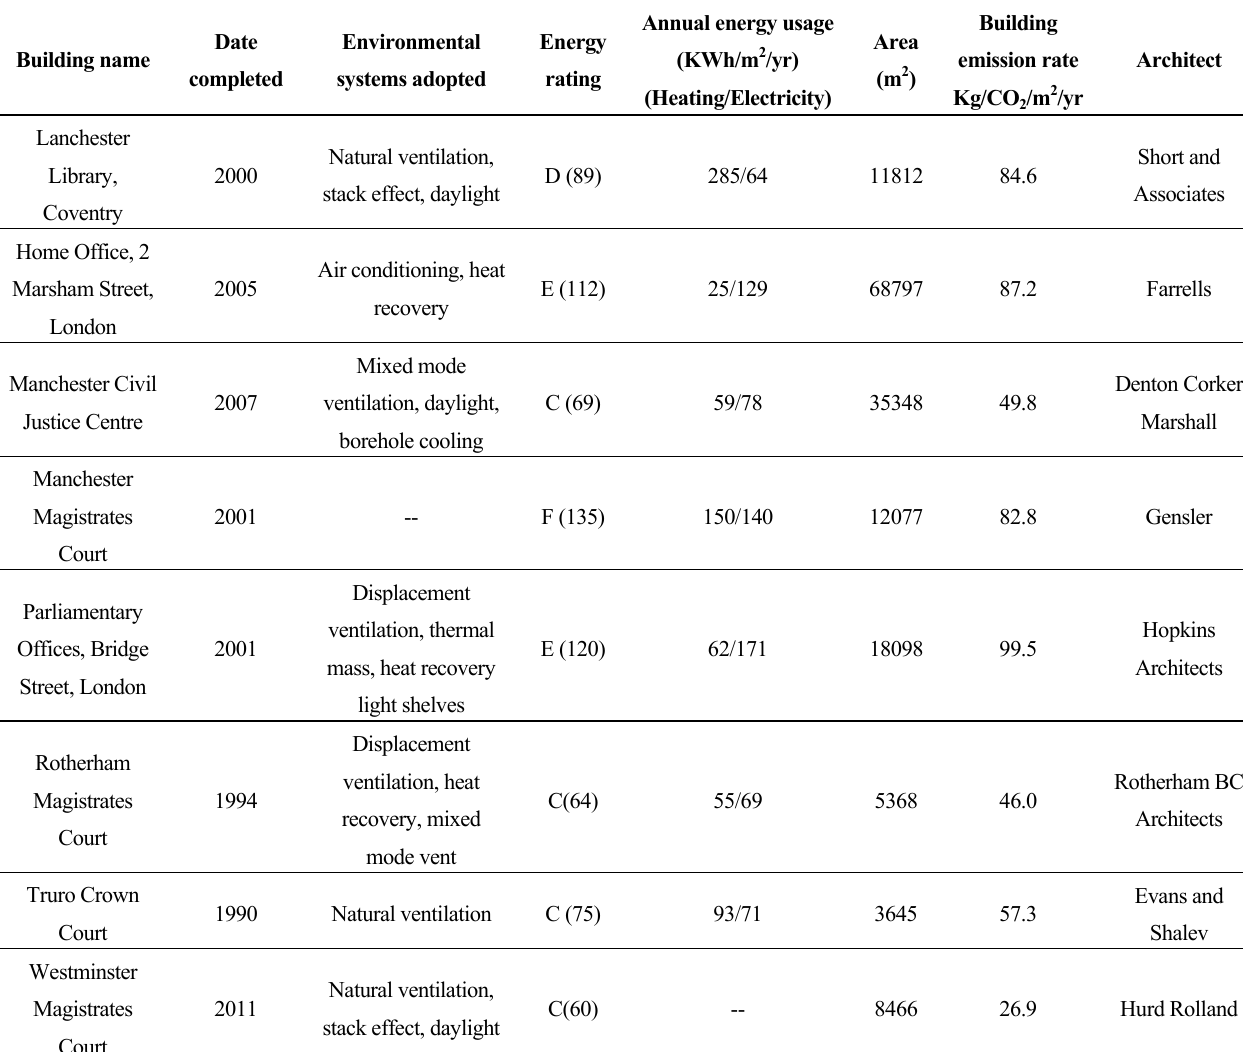
Table 1. Comparison of Display Energy